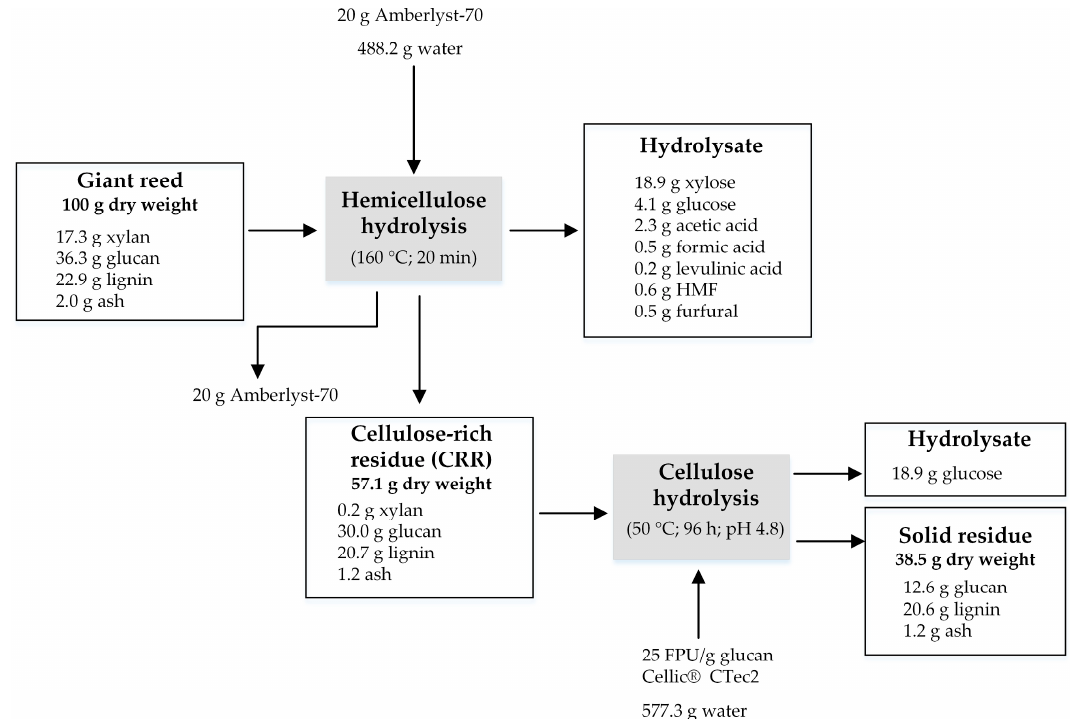
Figure 8. Mass balance flow diagram for chemical hydrolysis of raw giant reed and enzymatic hydrolysis of CRR, both of them under the optimised reaction conditions.